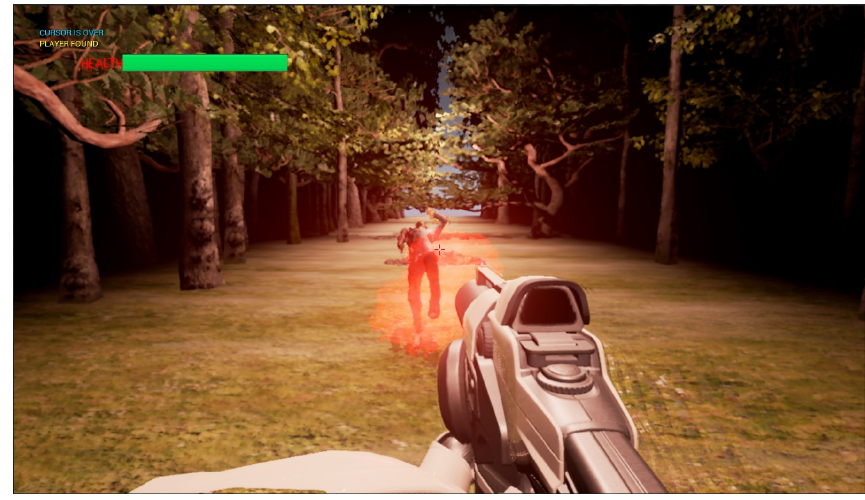
Figure 1. A zombie being killed in Zombie